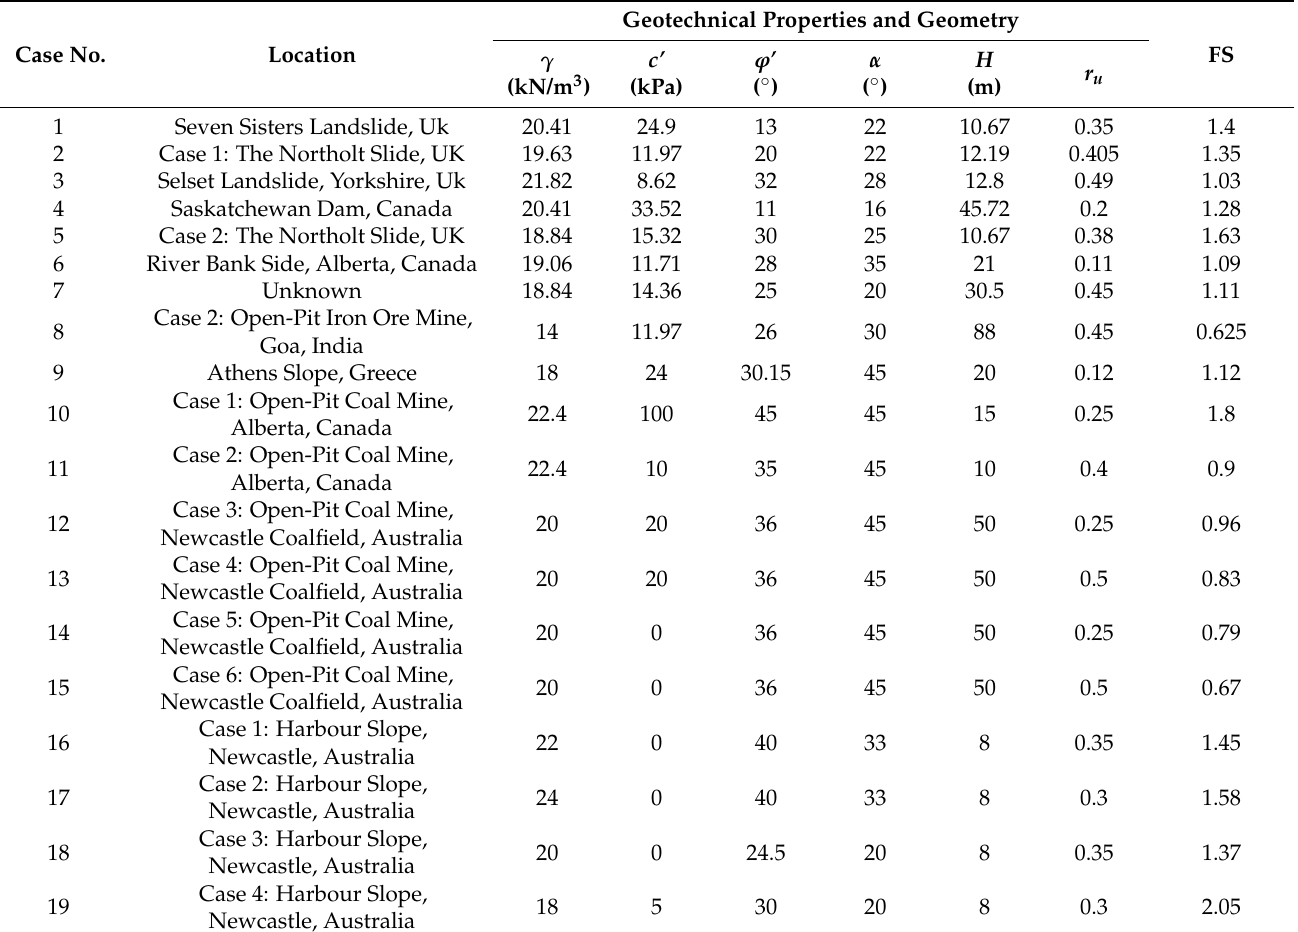
Table 2. Dataset considered in the present study (Sah et al.